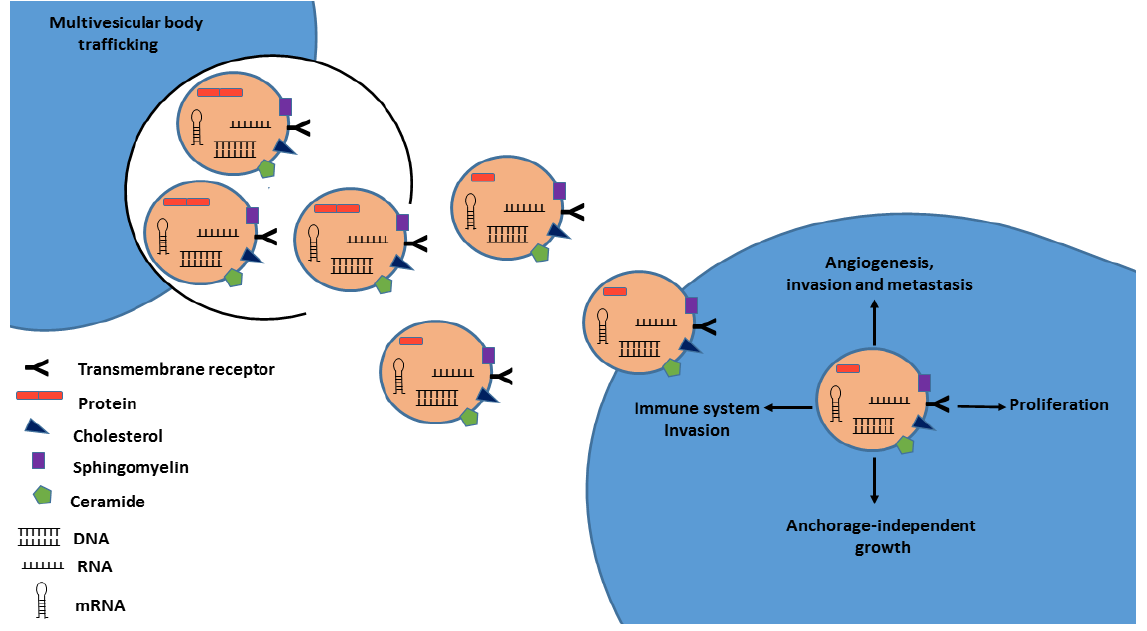
Figure 2. Schematic model of exosome secretion in cancer cells. Exosome membranes are enriched in cholesterol, sphingomyelin, and ceramide, as well as lipid raft associated proteins. These components allow exosomes to be highly stable in numerous body fluids. Exosomes released from cancer cells transport a variety of molecules (miRNAs, RNAs, DNA, proteins) and can be taken up by neighboring cells and are capable of inducing pathways involved in cancer initiation and